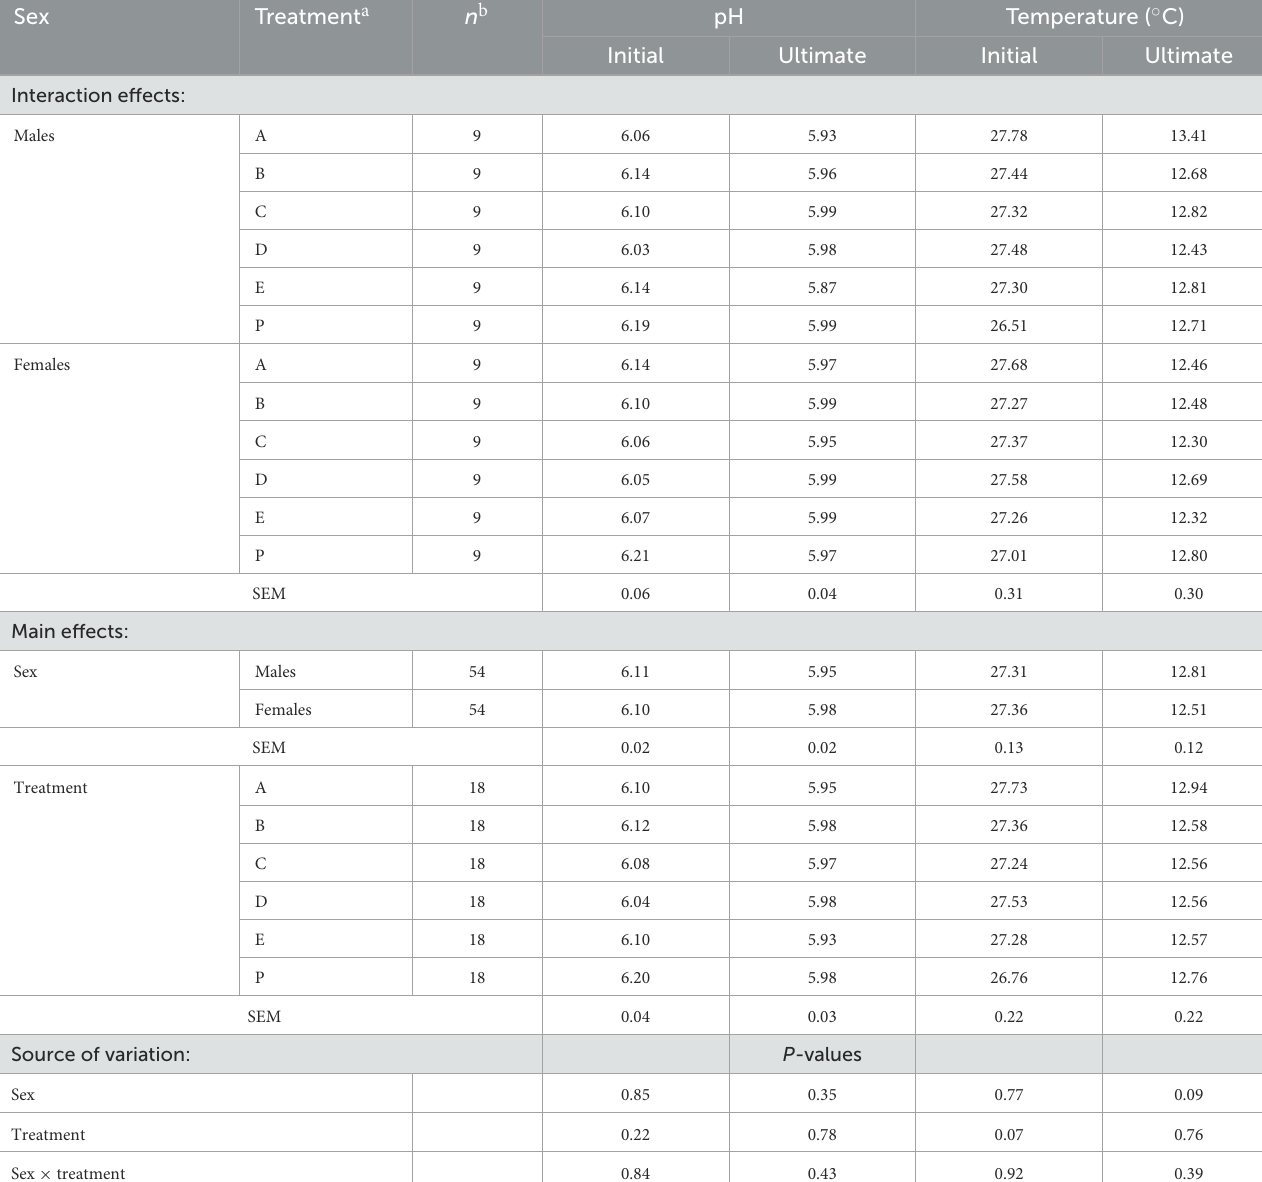
TABLE 4 Effects of adding nano-emulsified plant oil and probiotics to drinking water during different periods besides sex on breast meat pH and temperature of broiler chickens at 35 days of age. Sex Treatment a n b pH Temperature ( ◦ C) Initial Ultimate Initial